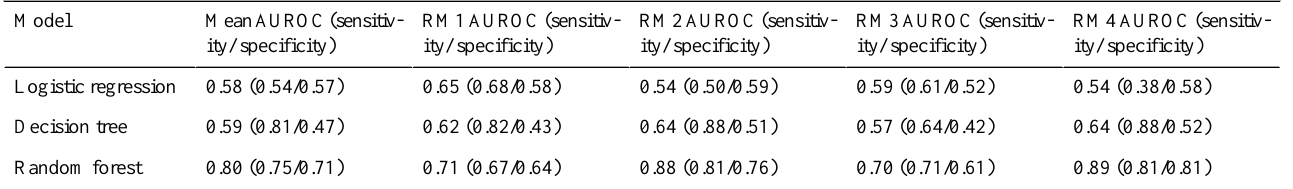
Table 3. Area under the receiver operating characteristic curve (AUROC; sensitivity/specificity) performance of the modeling strategies explored.